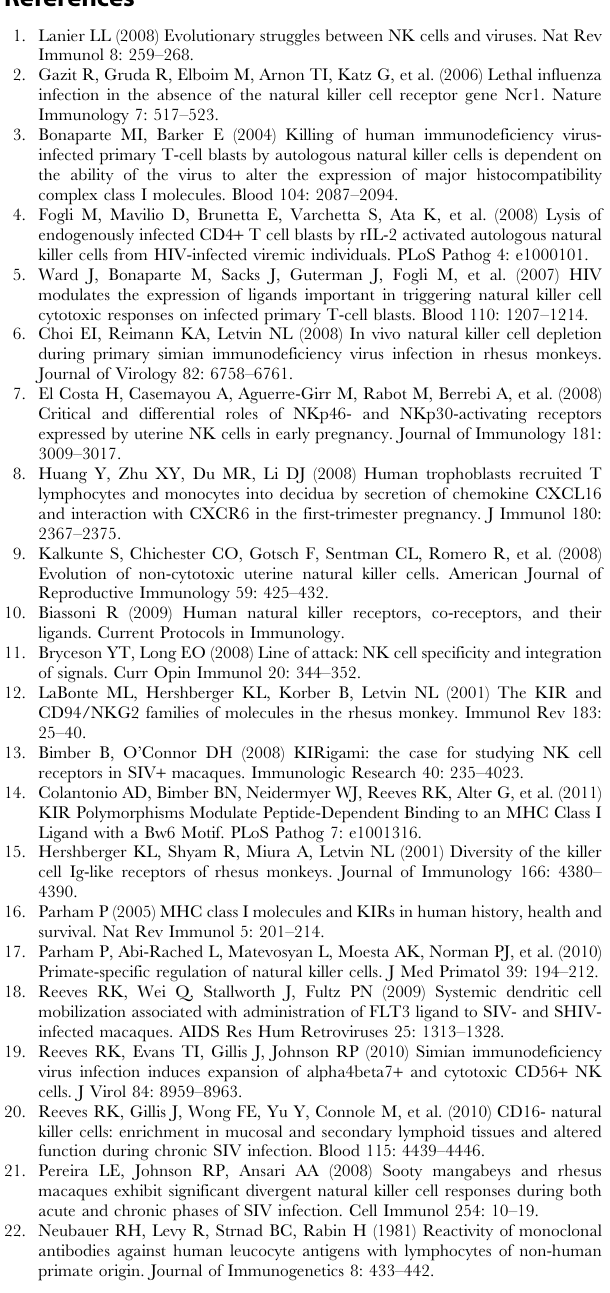
Figure S3 Cross-reactive staining of anti-CD8 a (B9_11) on neotropical primate lymphocytes. Figure S4 Cross-reactive staining of anti-CD56 on tamarin